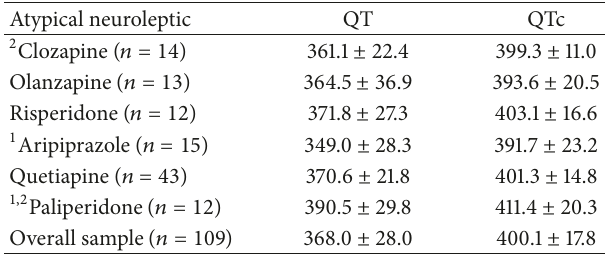
Table 2: QT/QTc mean durations in the sample and in treatment